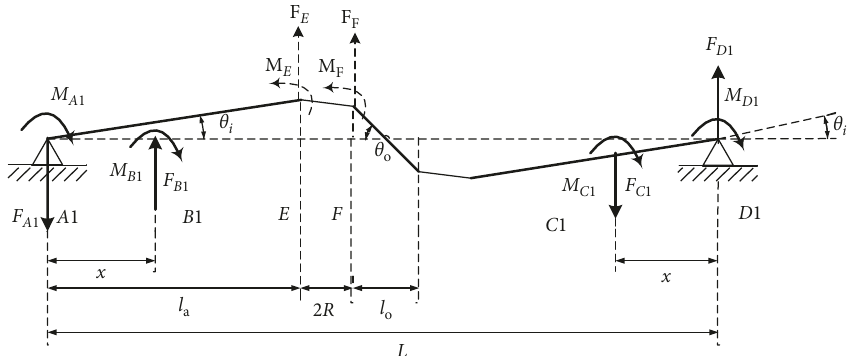
Figure 9: Simplified model of the nonuniform beam.